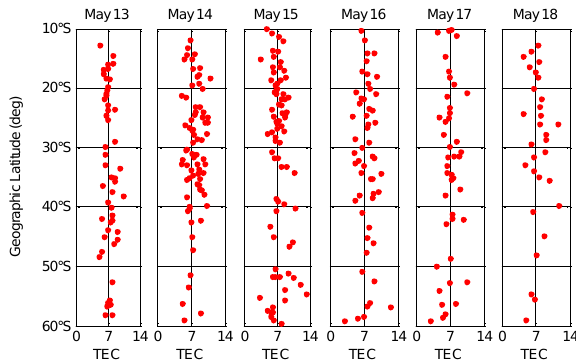
Figure 8 Changes in the VTEC data obtained by the Jason-1 satellite in the ascending orbit from May 13 to 18.